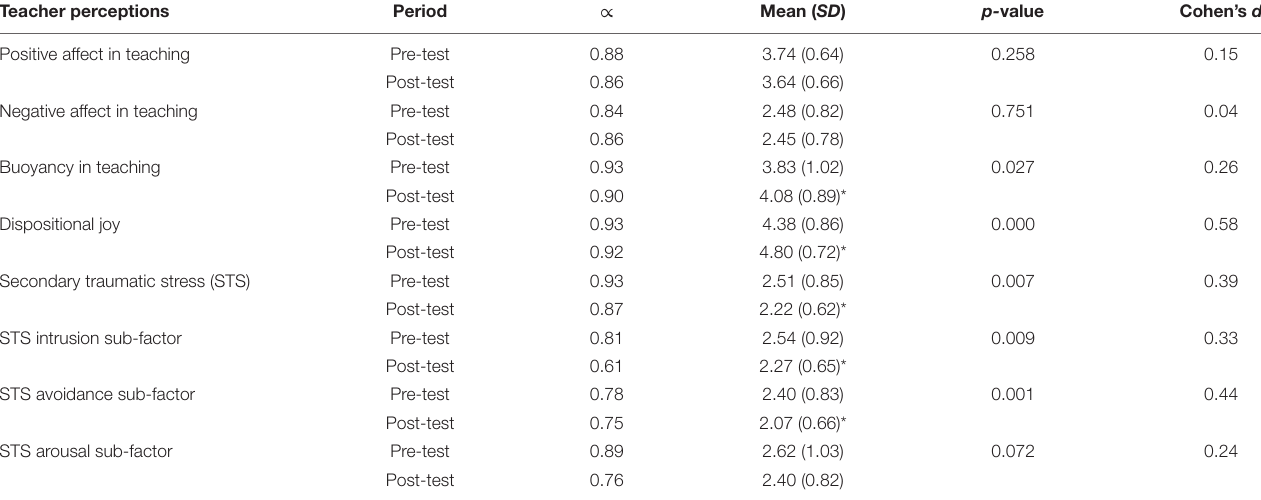
TABLE 3 | Results of within-teacher ANOVA for aspects of teacher wellbeing.